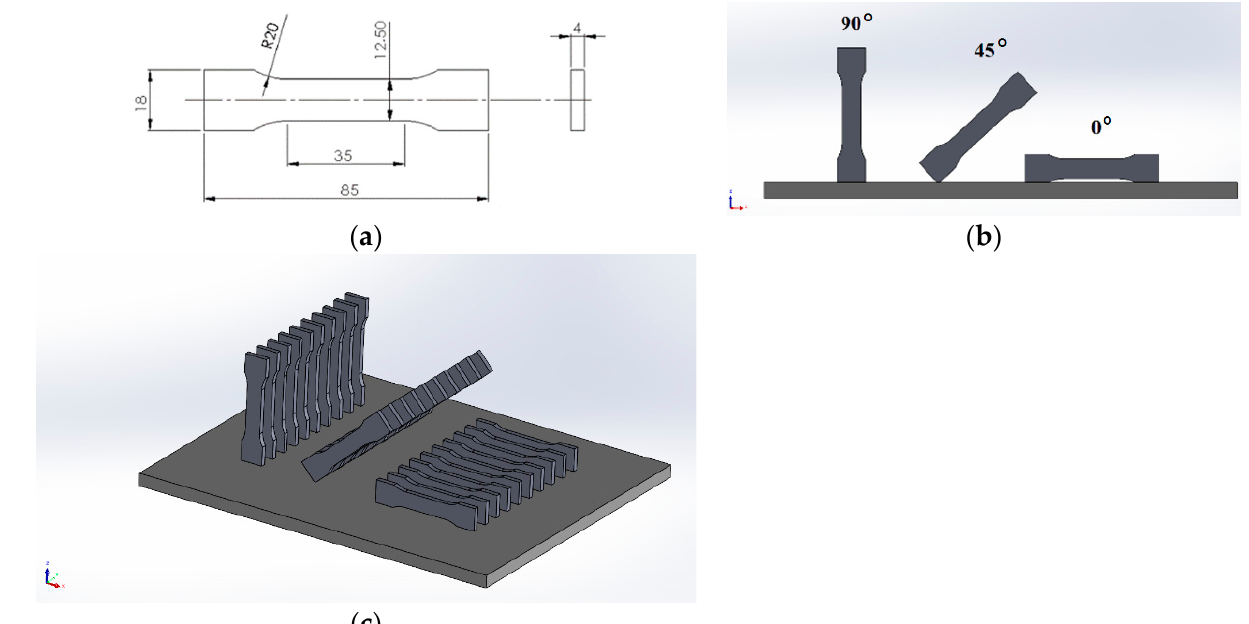
Figure 1. Sample placement on the 3D printer platform: ( a ) dimensions, mm; ( b ) 2D-view; ( c ) isometric view.